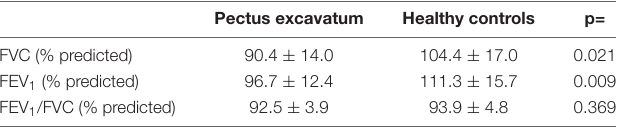
TABLE 2 | Pulmonary function test findings of participants investigated.